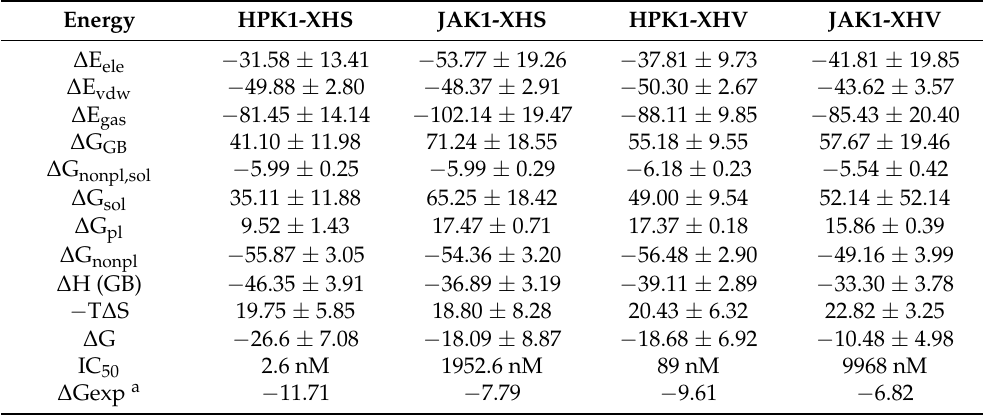
Figure 3. The RMSDs of four complexes. ( A ) HPK1-XHS complex, ( B ) HPK1-XHV complex, ( C ) JAK1-XHS complex, ( D ) JAK1-XHV complex. Table 1. Binding free energies for four systems and experimental binding free energies calculated from IC 50 values of two inhibitors on HPK1 and